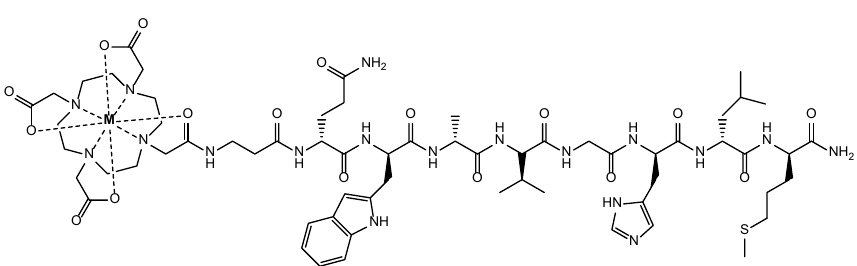
149 Pm, 153 Sm, 177 Lu =